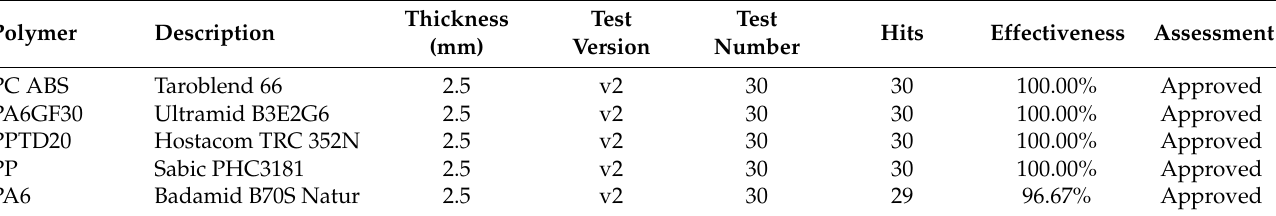
Table 4. Effectiveness tests for sensor 2.